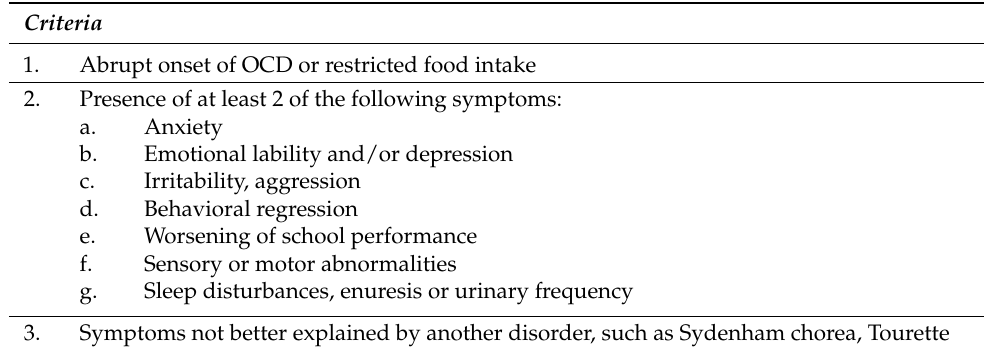
Table 1. Pediatric Acute-Onset Neuropsychiatric Disorders (PANS) diagnostic criteria. Modified from Swedo et al.